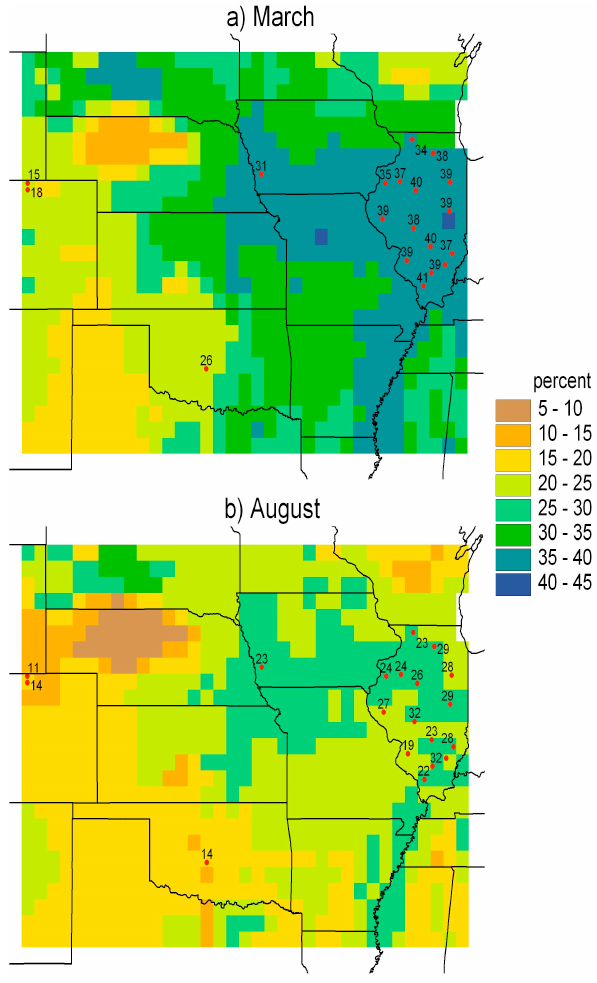
Fig. 7. Comparison of modeled (1951–1980) and observed (various record lengths) average volumetric soil moisture in the root zone: (a) March and (b) August. Observations are the red